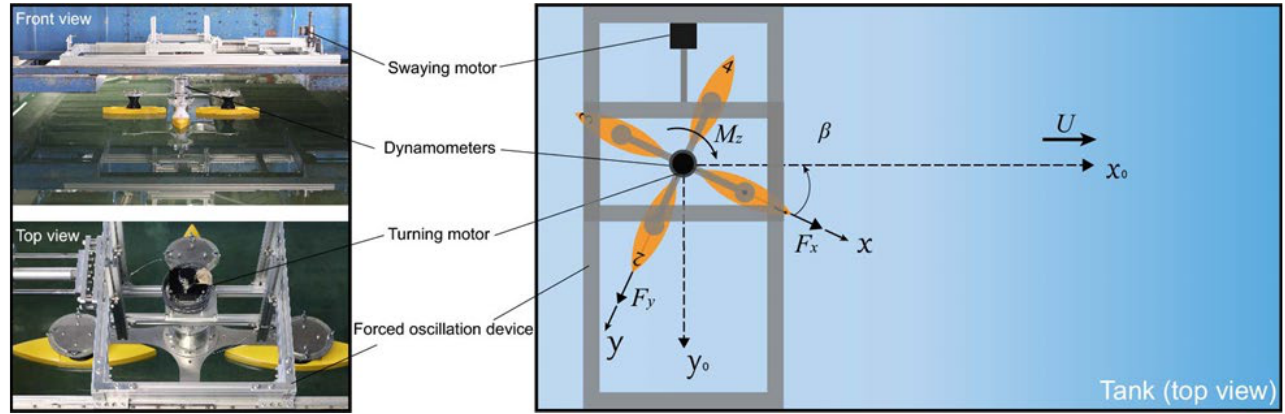
Figure 7. Oblique towing test.